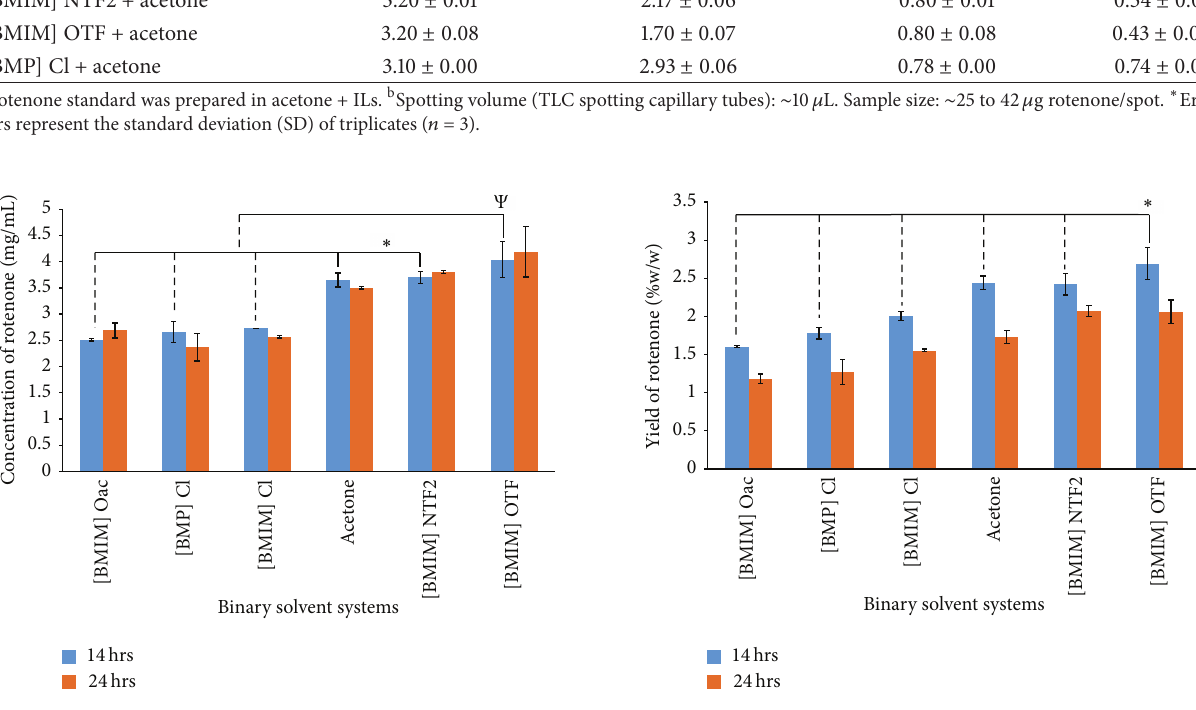
Figure 5: Yield of rotenone, % (w/w) in dried roots with respect to five different types of binary solvent systems. ∗ 𝑃 < 0.05 —[BMIMI] OTF + acetone is the best binary solvent system to procure the highest rotenone content in dried roots ( 𝑛 = 3 ) at the optimum time of extraction process (14hrs). Error bars represent the standard deviation (SD) of triplicates ( 𝑛 = 3